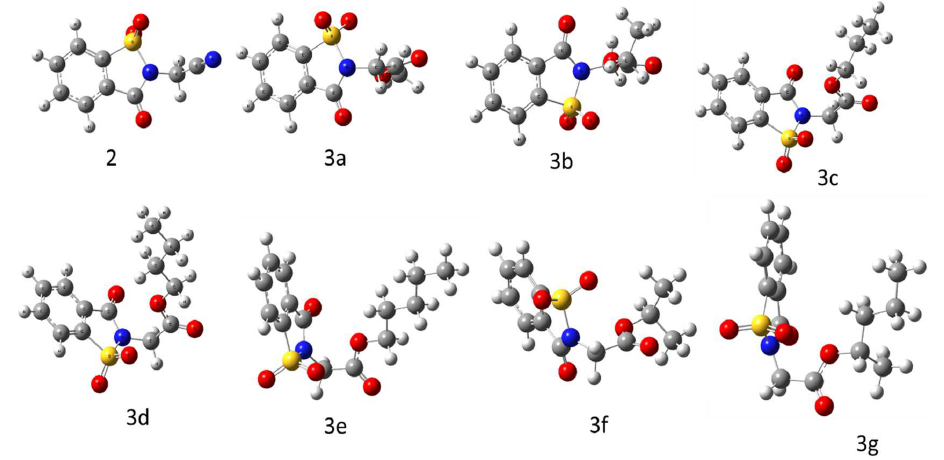
Figure 5. Optimized molecular structure of compounds 2 , and 3a – g in ball and stick type format.